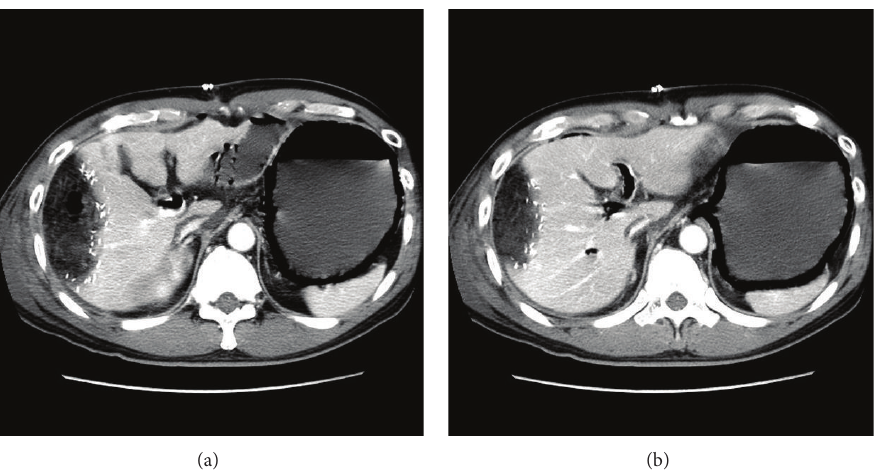
Figure 3: CT image confirming presence of gas in stomach wall. Gas is also noted in the portal vein.